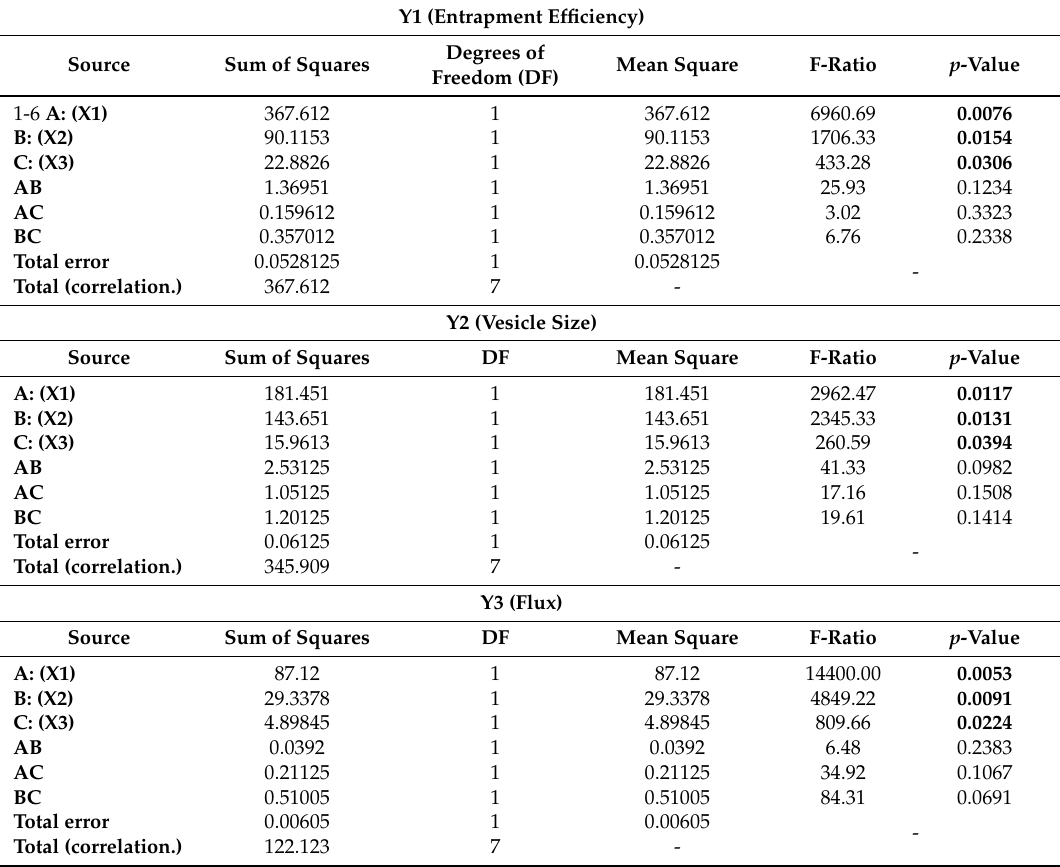
Table 4. ANOVA test for (Y1), (Y2), and (Y3) of the prepared MIC Transfersomes.